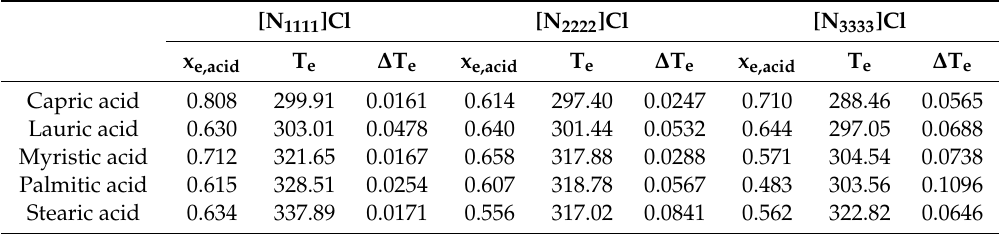
Table 1. Comparison of eutectic composition, eutectic temperature, and the normalized di ff erence between the eutectic temperature estimated using PC-SAFT and the melting temperature of the acids. Data are taken from